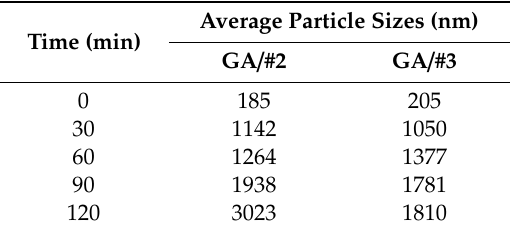
Figure 6. A dynamic light scattering of the GA/#2 ( left ) and GA/#3 ( right ) with incubation time. Table 4. Average sizes of the particles formed in the GA / #2 and GA / #3 with incubation time. Table 4. Average sizes of the particles formed in the GA/#2 and GA/#3 with incubation time. Time (min) Time (min)